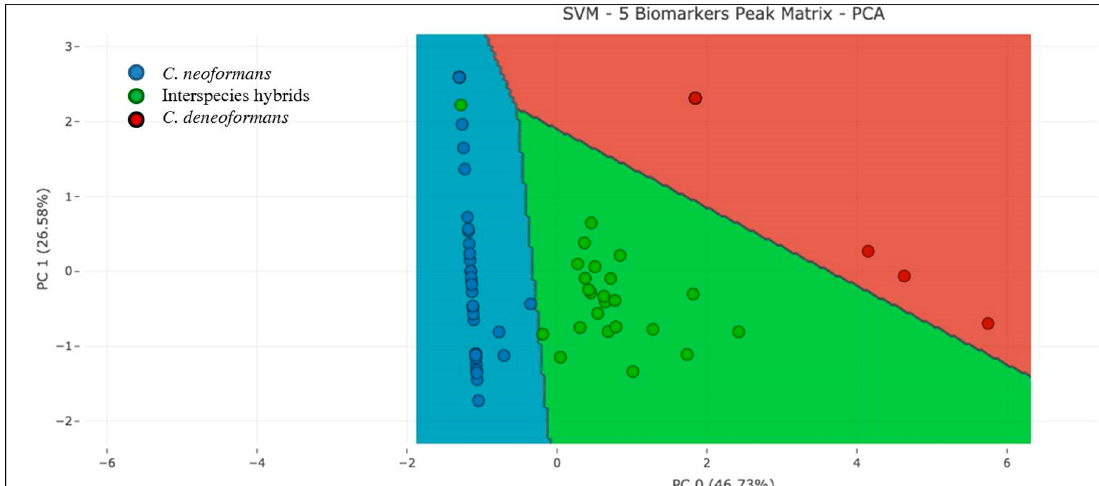
Figure 3. Classification of the three Cryptococcus species by support vector machine (SVM) in the one-step approach, using 5 biomarker peaks.